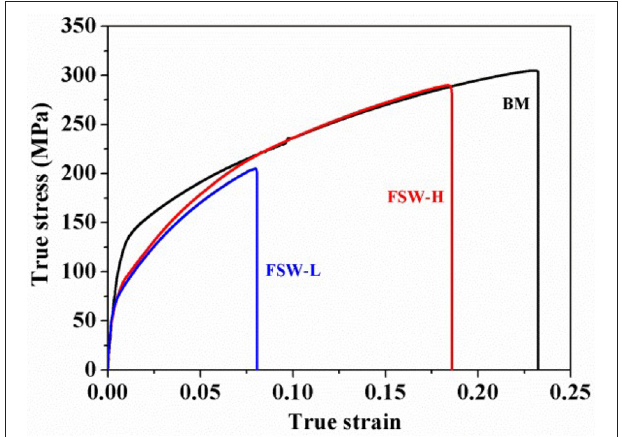
FIGURE 9 | Stress-strain curves of the as-received plate and FSW AZ31Mg alloys ( Xin et al., 2016) (Copyright © 2016, ELSEVIER BV).